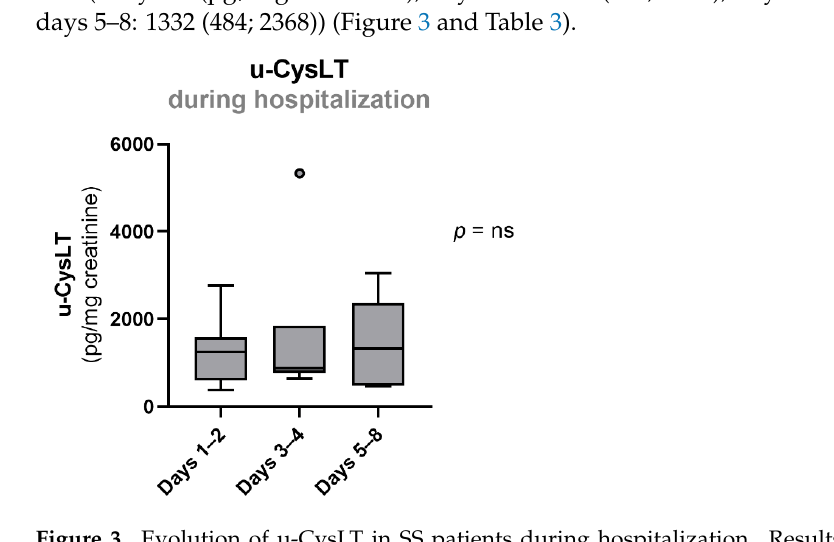
Figure 3. Evolution of u-CysLT in SS patients during hospitalization. Results are presented as box-and-whiskers plot, days 1–2 (n = 13), days 3–4 (n = 7), days 5–8 (n = 5); u-CysLT, urinary cysteinyl leukotrienes. Table 3. Evolution of biomarkers of endothelial activation, inflammatory status, oxidative stress, and systemic and intrarenal RAAS during hospitalization in SS patients.